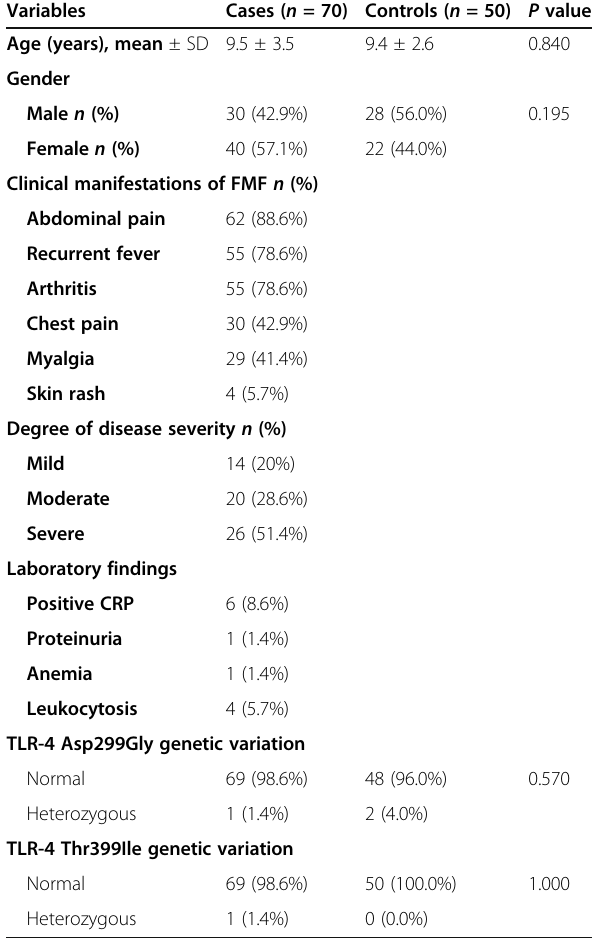
Table 2 Demographic, clinical, and laboratory characteristics of the studied groups regarding age, gender, clinical manifestations, disease severity, and presence of TLR4 gene